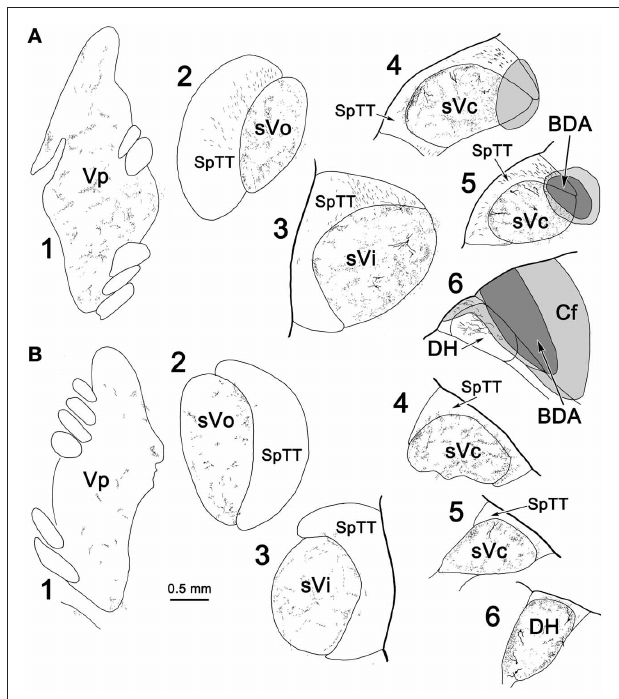
FIGURE 11 | The pattern of labeling in the ipsilateral (A) and contralateral (B) trigeminal complex following a small injection of sVc. A BDA injection was placed in sVc at spinal cord level C 2 . It only occupied the dorsal edge of the nucleus, but spread into the cuneate fasciculus (Cf) and the dorsal horn caudal to C 2 ( A 4 – 6 )